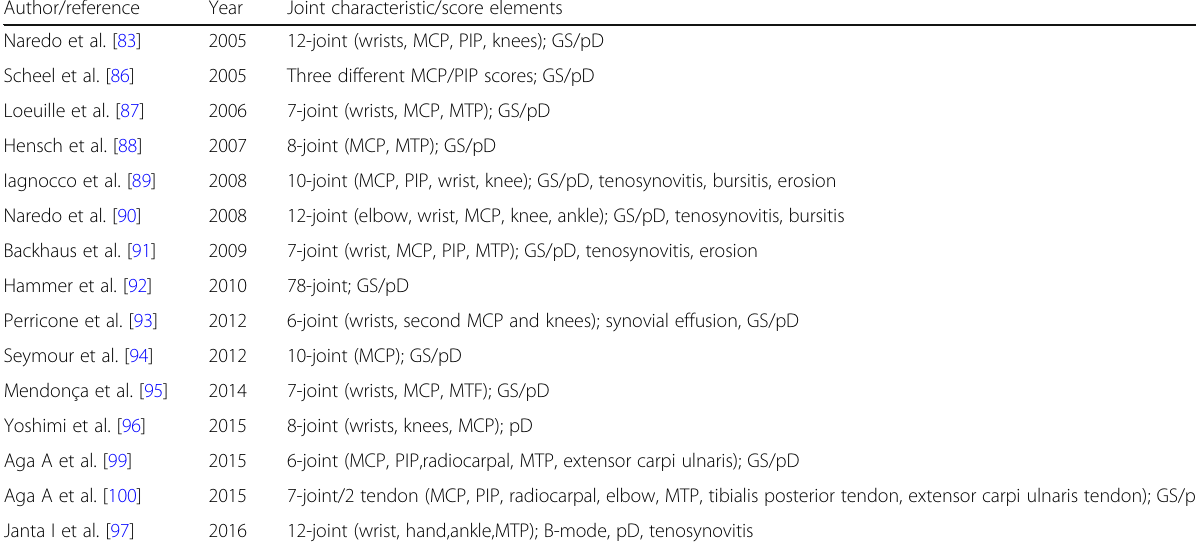
Table 1 Musculoskeletal ultrasound scores described in chronological order